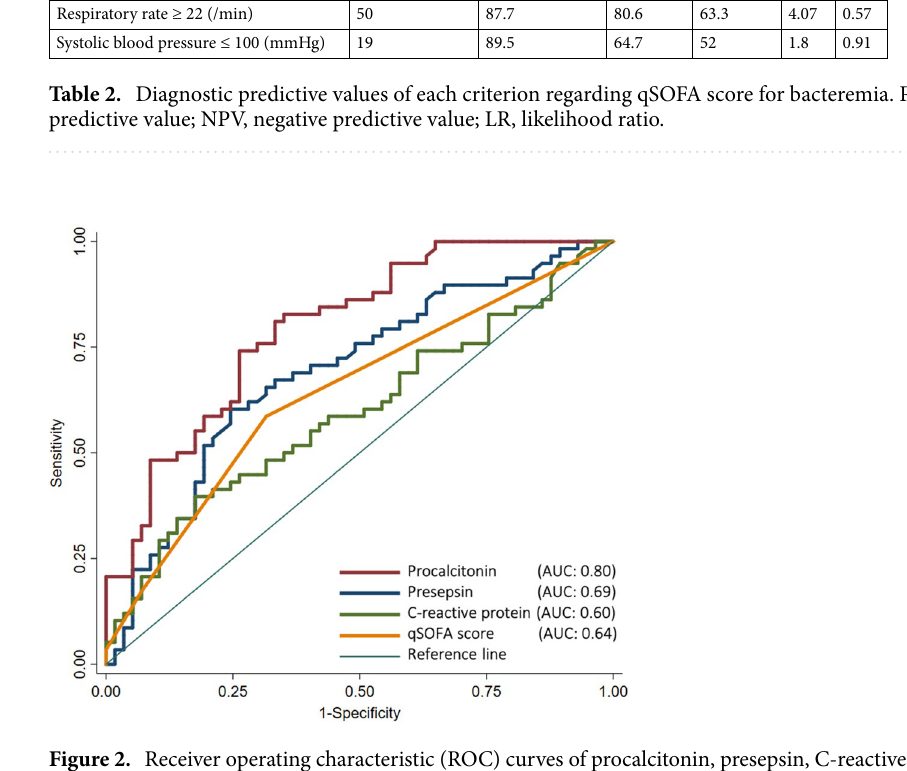
ROC curve analysis on diagnostic performance. Among the biomarkers, ROC curve analysis revealed that the highest performance for predicting bacteremia was procalcitonin (AUC 0.80; 95% CI: 0.72–0.88), fol- lowed by presepsin (AUC 0.69; 95% CI 0.60–0.79), and CRP (AUC: 0.60; 95% CI 0.49–0.70; Fig. 2). The AUC of procalcitonin was significantly higher than that of CRP ( p < 0 .001); however, the AUCs were not significantly different between presepsin and CRP (p = 0.50). The estimated optimal cut-off value of procalcitonin was 0.377 ng/mL, with a sensitivity, specificity, and positive LR of 74.1%, 73.7%, and 2.82, respectively, while that of prese- psin was 407 pg/mL, with a sensitivity, specificity, and positive LR value of 60.3%, 75.4%, and 2.46, respectively (Table 3). The AUC of the qSOFA score for predicting bacteremia was 0.64 (95% CI 0.55–0.73; Figure 2). The per- formance of body temperature and respiratory rate as predictors of bacteremia were AUCs of 0.73 (95% CI: 0.63–0.82) and 0.74 (95% CI: 0.65–0.83), respectively (Suppl Figure S1). However, leukocytosis (AUC: 0.58;